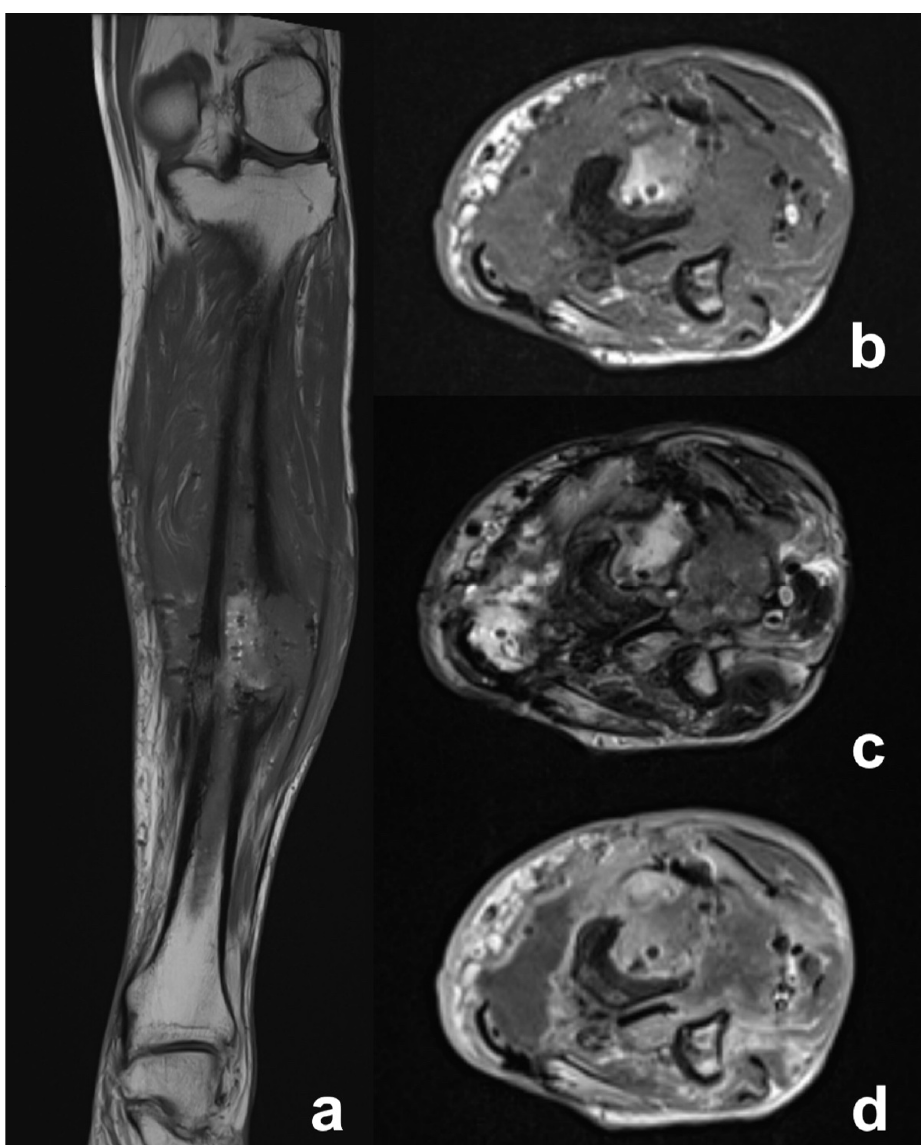
Figure 4. Post-debridement MRI. ( a ) Cor T1-w shows abnormal, low marrow intensity signals of the tibial diaphysis around the area communicating with fistula. On the lateral side of tibial cortex, there is an ill-defined soft tissue mass isointense to muscle. ( b ) Tra T1w shows the same features of the pre-operative magnetic resonance. ( c ) Tra T2 w image demonstrates lateral mass in continuity with the lateral sinus tract and high signal of medullary canal. The mass shows well-defined margins and homogeneous low-intensity signal. It is visible on the medial aspect of the other sinus tract and a heterogeneous fluid collection is developing on the posteromedial side with intermediate-to-high signal. ( d ) Fat-sat Tra T1-w gadolinium-enhanced MR image shows mild enhancement of periosteum, as well as of lateral sinus tract and adjacent mass. On the other aspect, significant enhancement of the medial sinus tract is present, as is a large fluid collection with peripheral enhancement, which characterizes an intramuscular abscess.